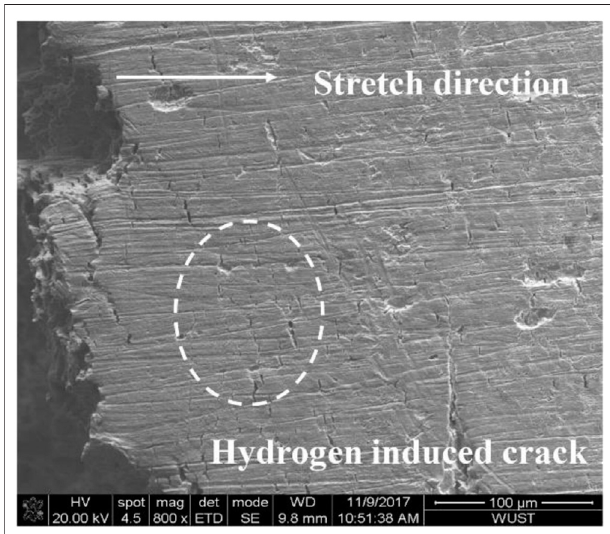
FIGURE 6 | Lateral fracture surface morphology of DP steel with martensite content in